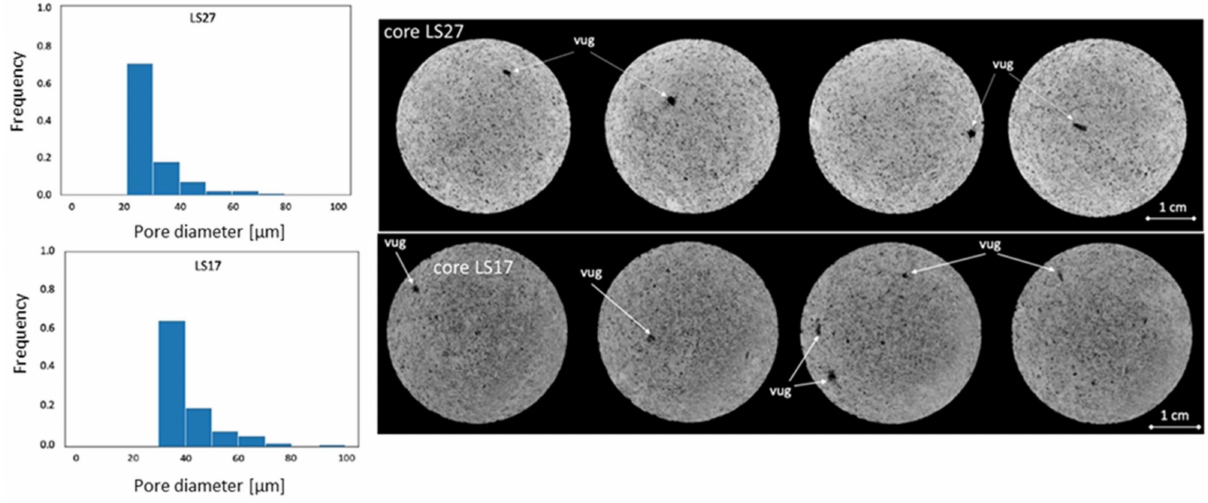
Figure 1. Pore size distribution ( left ) and micro-CT images ( right ) of two Edwards limestone cores: one of lower (LS27) and one of higher (LS17) permeability. The spatial resolution of images was 25 µ m, and smaller pores are, hence, not visible in the images. The majority of pores were below 50 µ m in